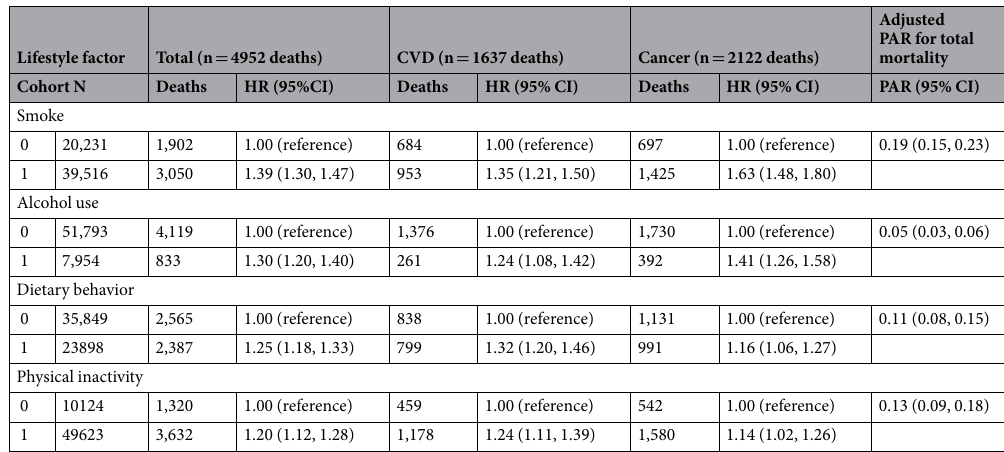
Table 3. Hazard ratios of all-cause, cardiovascular, and cancer mortality in relation to individual lifestyle factors, the Shanghai Men’s Health Study (2002–2013, n = 59,747). N: number; HR: adjusted for age group, education, income per person, occupation, history of hypertension, diabetes mellitus, coronary heart disease, and stroke and other individual lifestyle factor; CI: confidence interval; PAR: population attributable risk; 0: Not at risk; 1: At